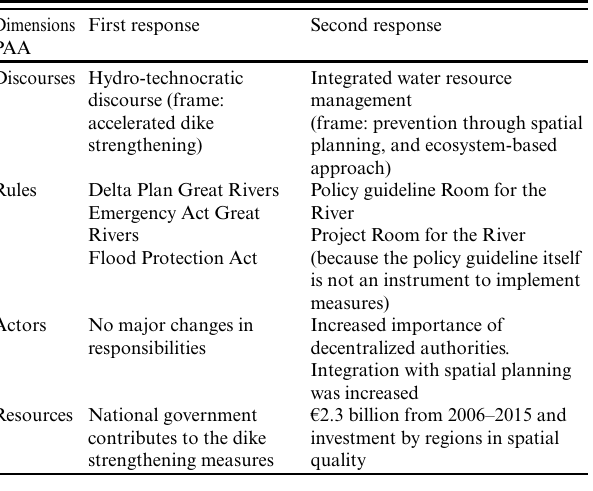
Table 6 . Institutional consequences after the flood of 1995.